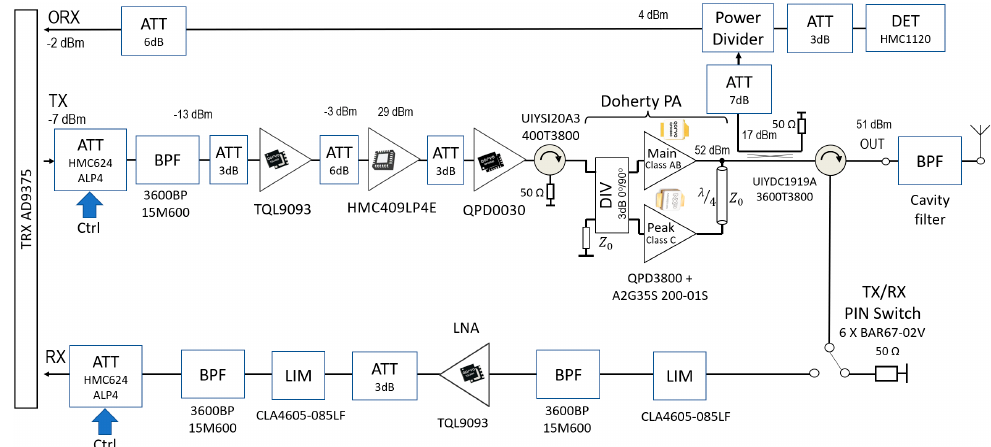
Figure 4. Block diagram of the single B43 RF channel.